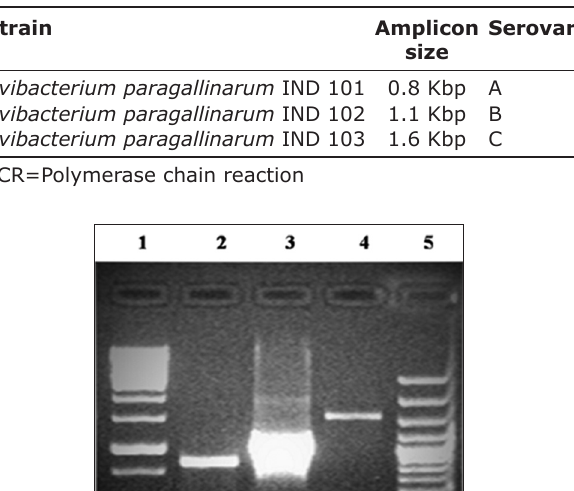
Table-2: Multiplex PCR assay of Avibacterium paragallinarum.